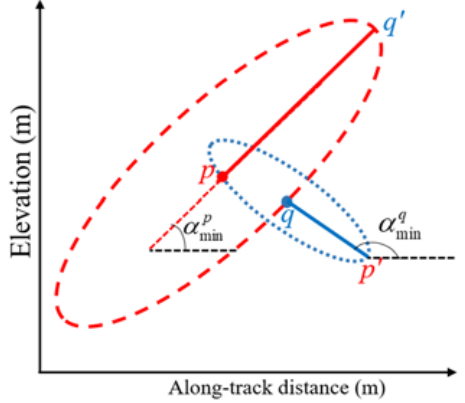
Figure 4. Schematic diagrams of backward elliptical distance [21].